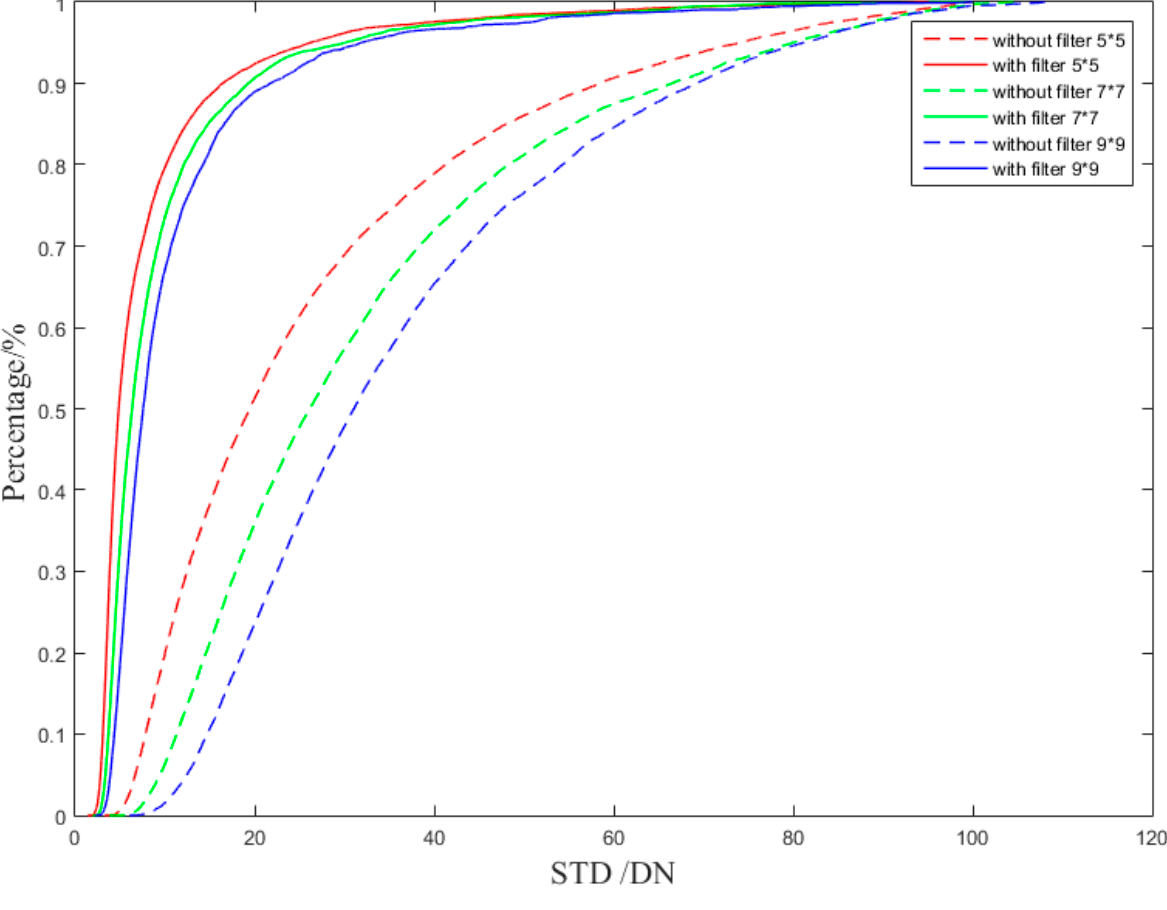
Figure 23. Local regional standard deviation (STD) probability density curve comparison of the corrected images.